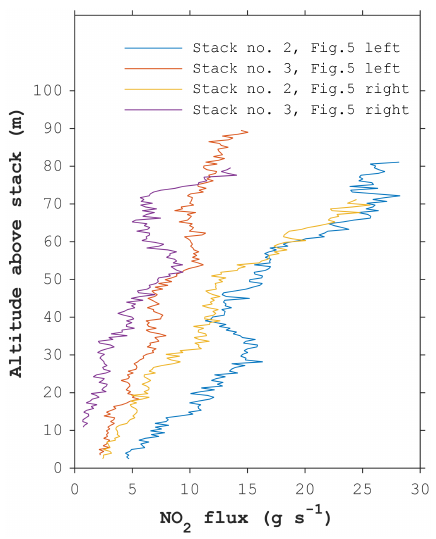
Figure 6. NO 2 flux computed through the plume horizontal cross section as a function of altitude. Stacks height is 280m. A sym- metric Gaussian dispersion is assumed up to the region of apparent intersection of the two